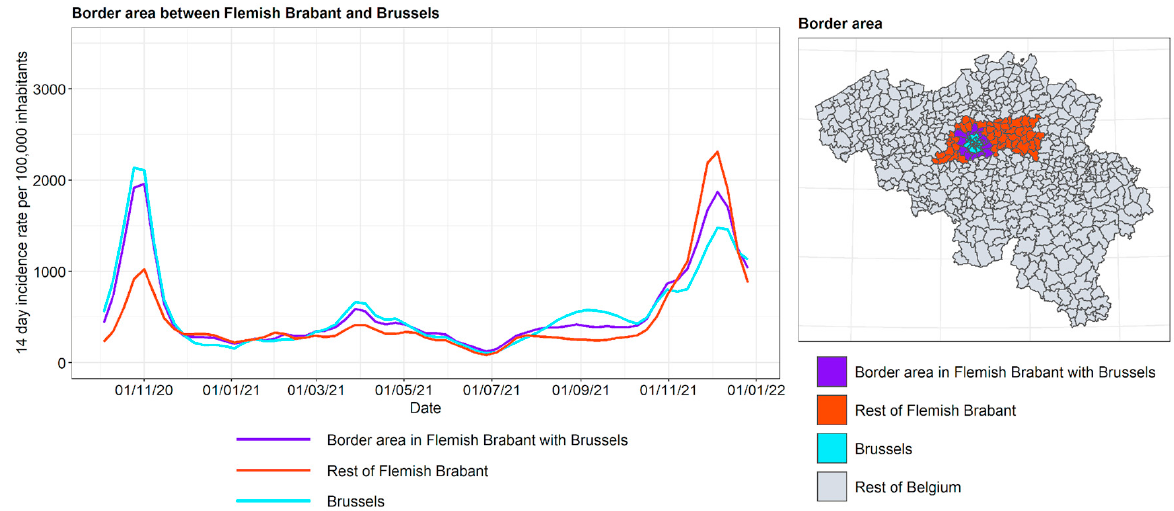
Figure 19. COVID-19 incidence curves for the border area in Flemish Brabant with Brussels.